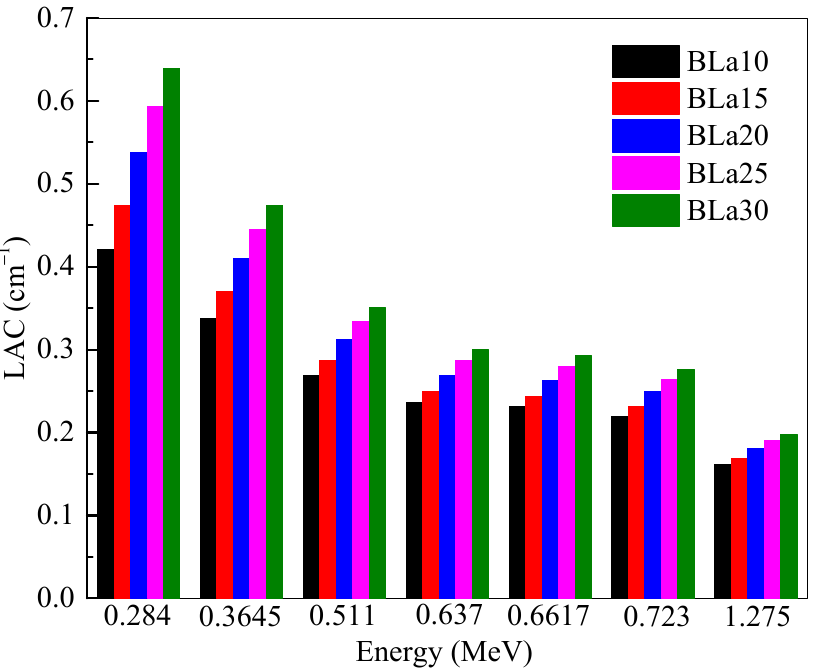
Figure 1. Linear attenuation coefficient of the shielding samples at 0.284, 0.3645, 0.511, 0.637, 0.6617, 0.723 and 1.275 MeV.